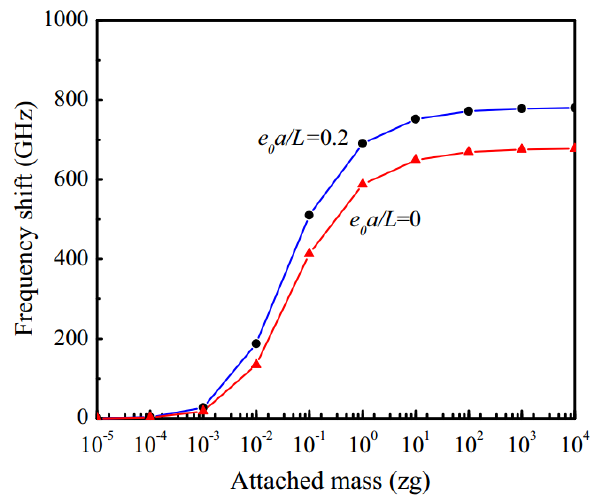
Figure 10. Effect of the nonlocal coefficient on the resonant frequency of the CNTs under attached different nanomasses. Adapted with permission from [43], Copyright Springer, 2015.